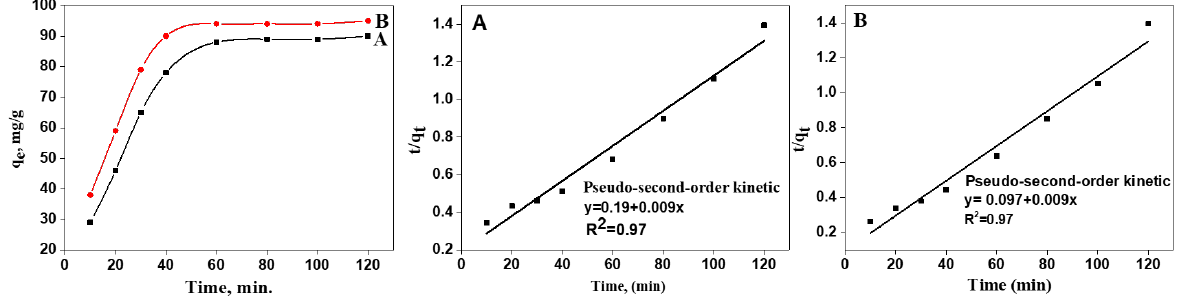
Figure 5. Effect of the adsorption time on adsorption capacity, and the adsorption kinetic fittings of TOCNF1 ( A ) and TOCNF2 ( B ).